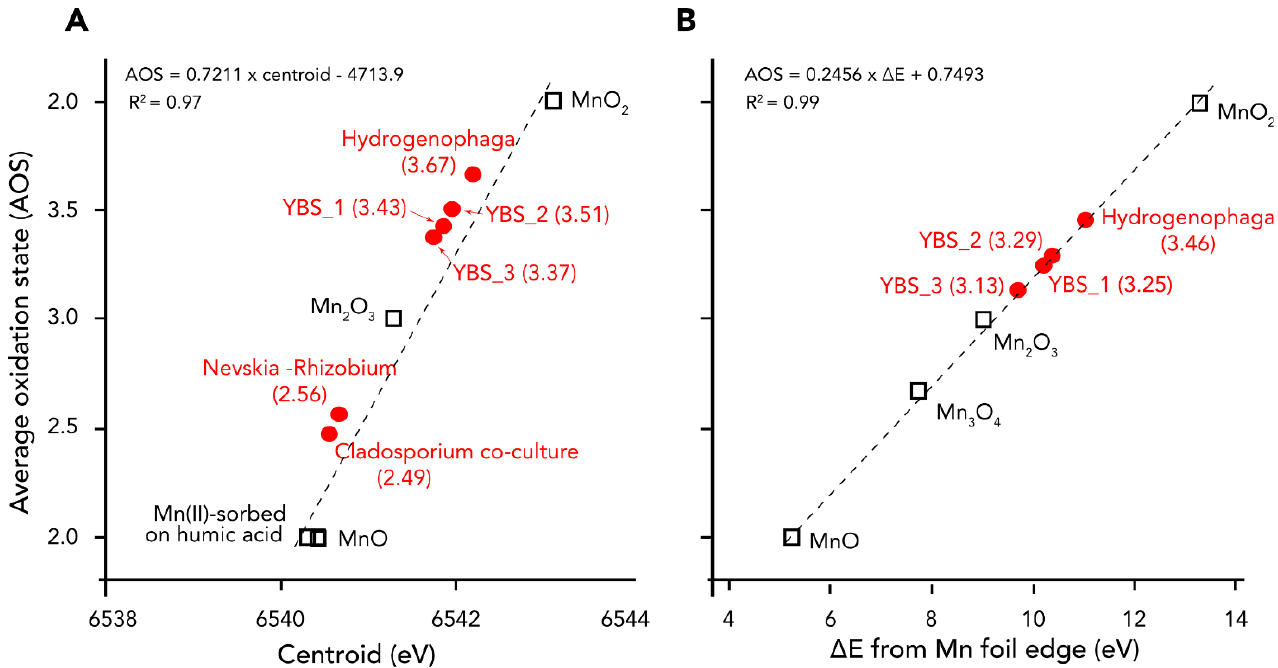
Figure 9. ( A ) Estimation of average oxidation state (AOS) of Mn in samples, using a calibration curve established based on a linear correlation between Mn oxidation state and pre-edge centroid energies of selected reference compounds with similar Mn coordination environment in the first shell as the samples (detailed information are given in Figure S4). ( B ) For the samples with a dominance of MnO x , AOS of Mn was also estimated based on the energy shifts on the absorption edge relative to Mn foil (ΔE) of known Mn oxidation states. The estimated AOS of Mn for each sample is also indicated in parentheses.